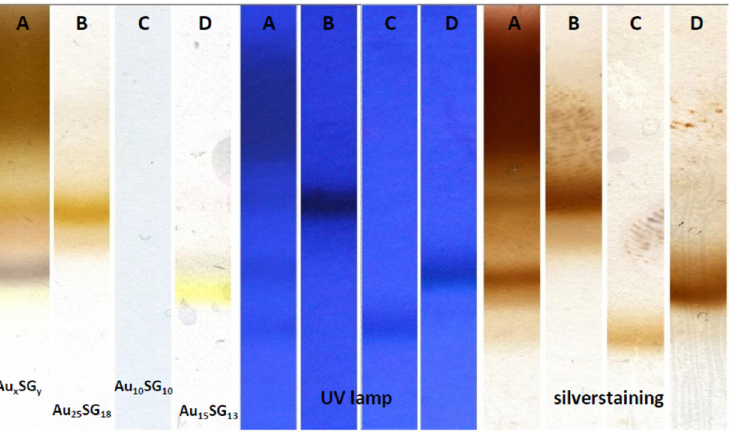
Figure 3. Polyacrylamide gel electrophoretic (PAGE) based separation of Au 10 (SG) 10 from Au 15 (SG) 13 and Au 25 (SG) 18 . Reprinted from Supporting Information Ref. [35]. Copyright 2017 American Chemical Society.